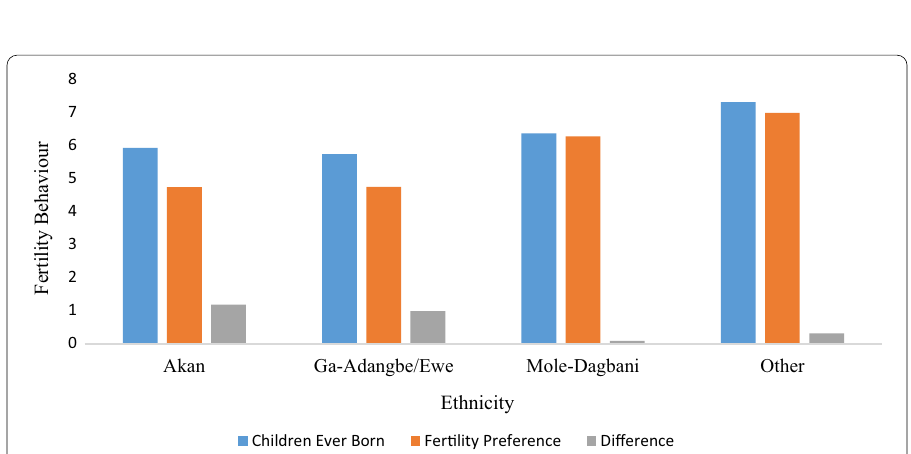
Fig. 3 Association between ethnicity and fertility behaviour, Ghana, 2008 GDHS Source: Generated from the GDHS